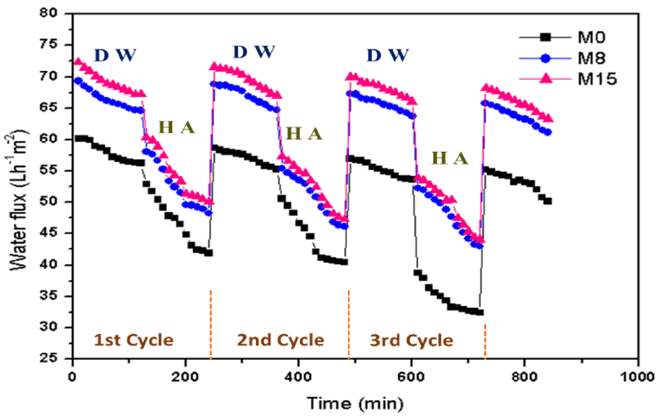
Figure 7. Time versus fluxes during three cycles of the HA UF experiment of the prepared membranes.